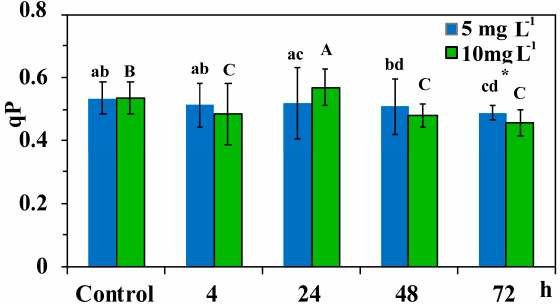
Figure 8. The photochemical quenching ( q p ) in control leaf blades of C. nodosa and in leaf blades exposed to 5 mg L − 1 and 10 mg L − 1 ZnO NPs for 4 h, 24 h, 48 h and 72 h. Symbol explanations as in Figure 5.